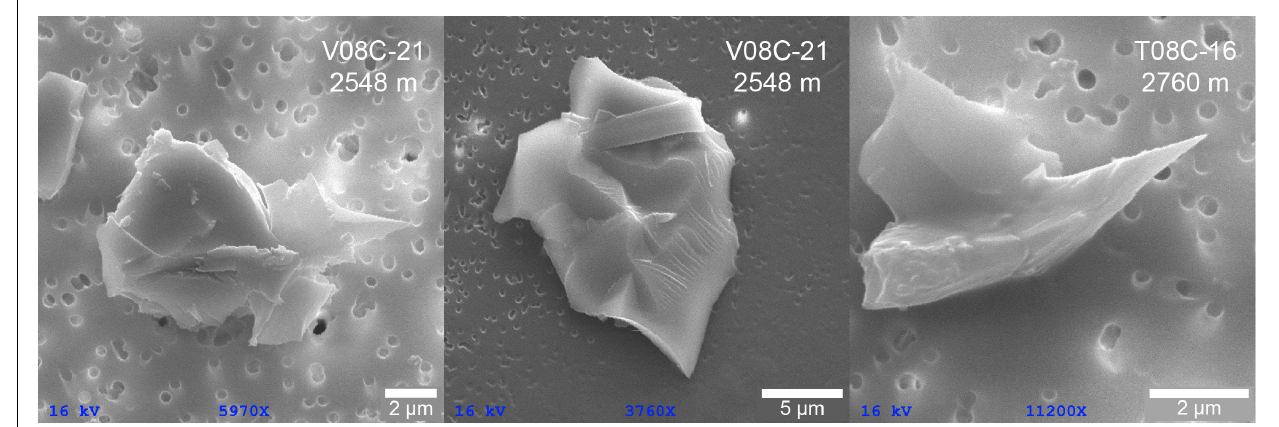
FIGURE 6 | SEM images of shards in deep plumes. Sample depths are shown by diamond symbols in Figure 3B